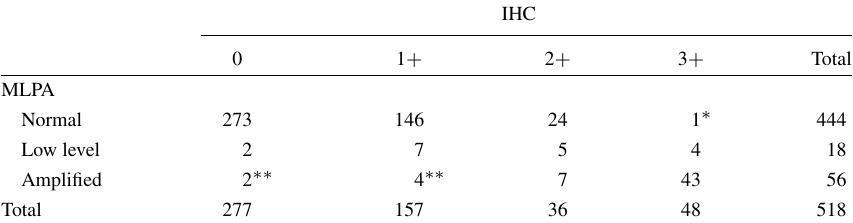
Comparison of HER-2/ neu protein overexpression by immunohistochemistry (IHC) with gene amplification by multiplex ligation-dependent probe amplification (MLPA) in 518 invasive breast cancer